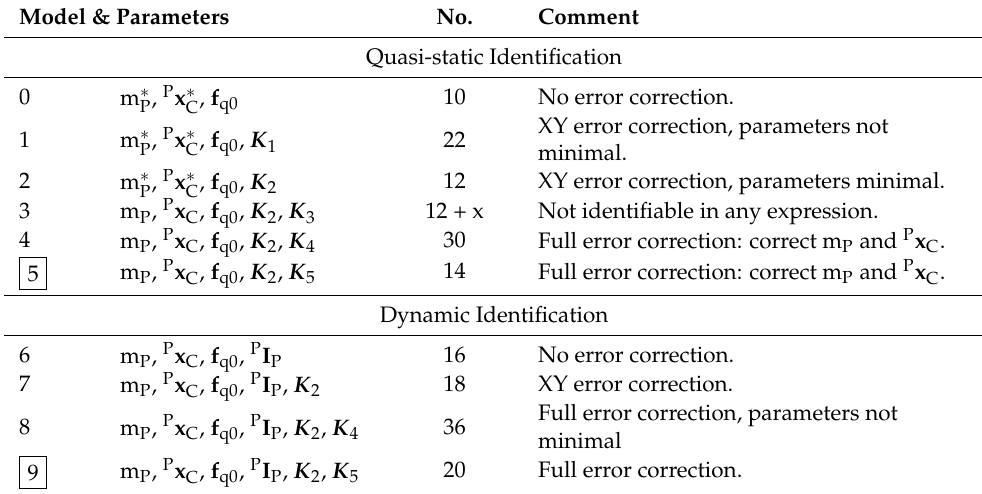
Table 2. Identification modelling approaches with parameters, No.: Number of parameters, Identifi- cation results are presented in Table 3; In squares: selected models for excitation optimisation. Model & Parameters No. Comment